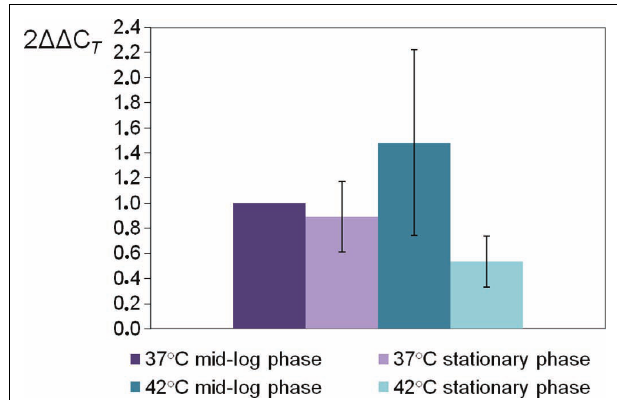
FIGURE 1 | Relative expression levels of C. jejuni 81-176 pnp gene at different conditions. Gene expression has been estimated using RT-qPCR and the comparative critical threshold ( (cid:2)(cid:2) C T ) method.The rpo A gene was used as the internal control, and the expression at 37 ◦ C in mid-log phase as the calibrator. Error bars represent the standard deviations from the mean of three independent experiments.